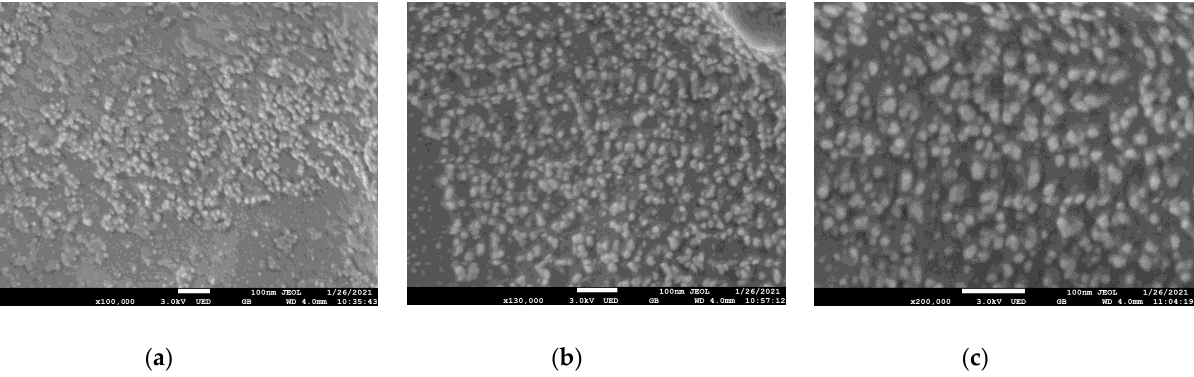
Figure 3. FESEM micrographs of 2:1 molar ratio inulin–TEOS at ( a ) 100 k, ( b ) 130 k, and ( c ) 200 k